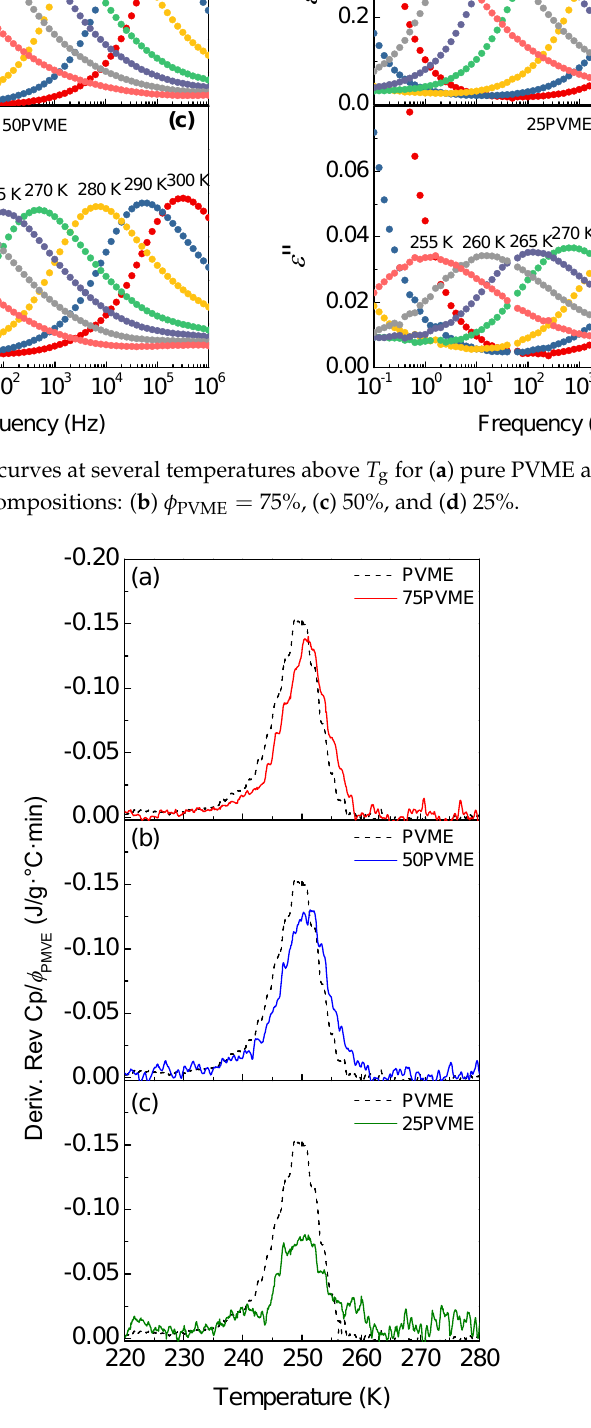
Figure 6. Derivative of the reversing heat capacity (normalized by the PVME weight fraction φ PVME ) for PVME and the mixtures: ( a ) 75PVME, ( b ) 50PVME, and ( c )